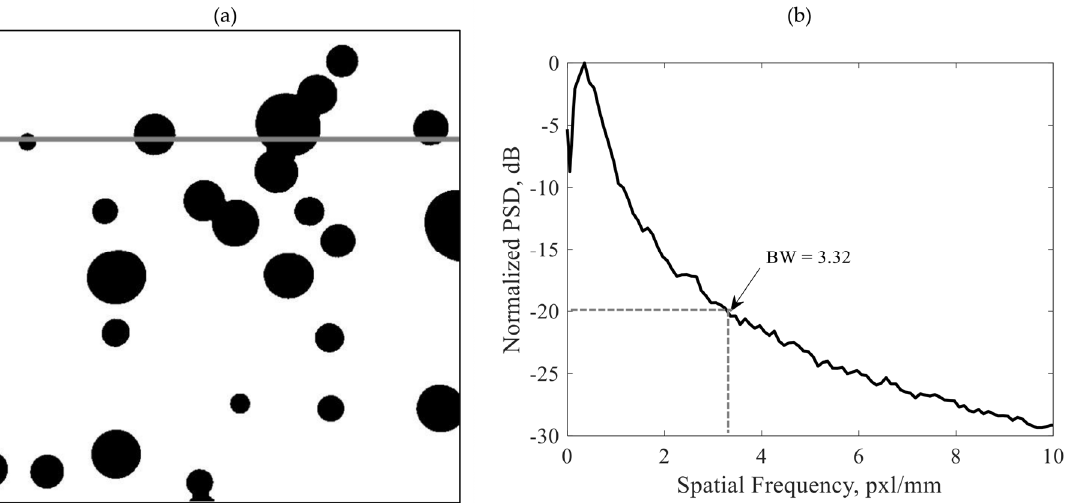
Figure 2. ( a ) Example of binary image, and ( b ) normalized power spectral density and bandwidth estimation. Table 3. List of studied region and object properties.